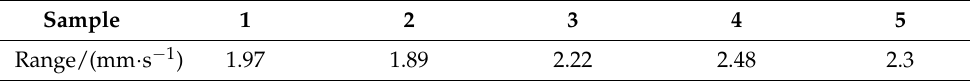
Table 3. The burning rate range of B/NC/CuO thermites. Sample 1